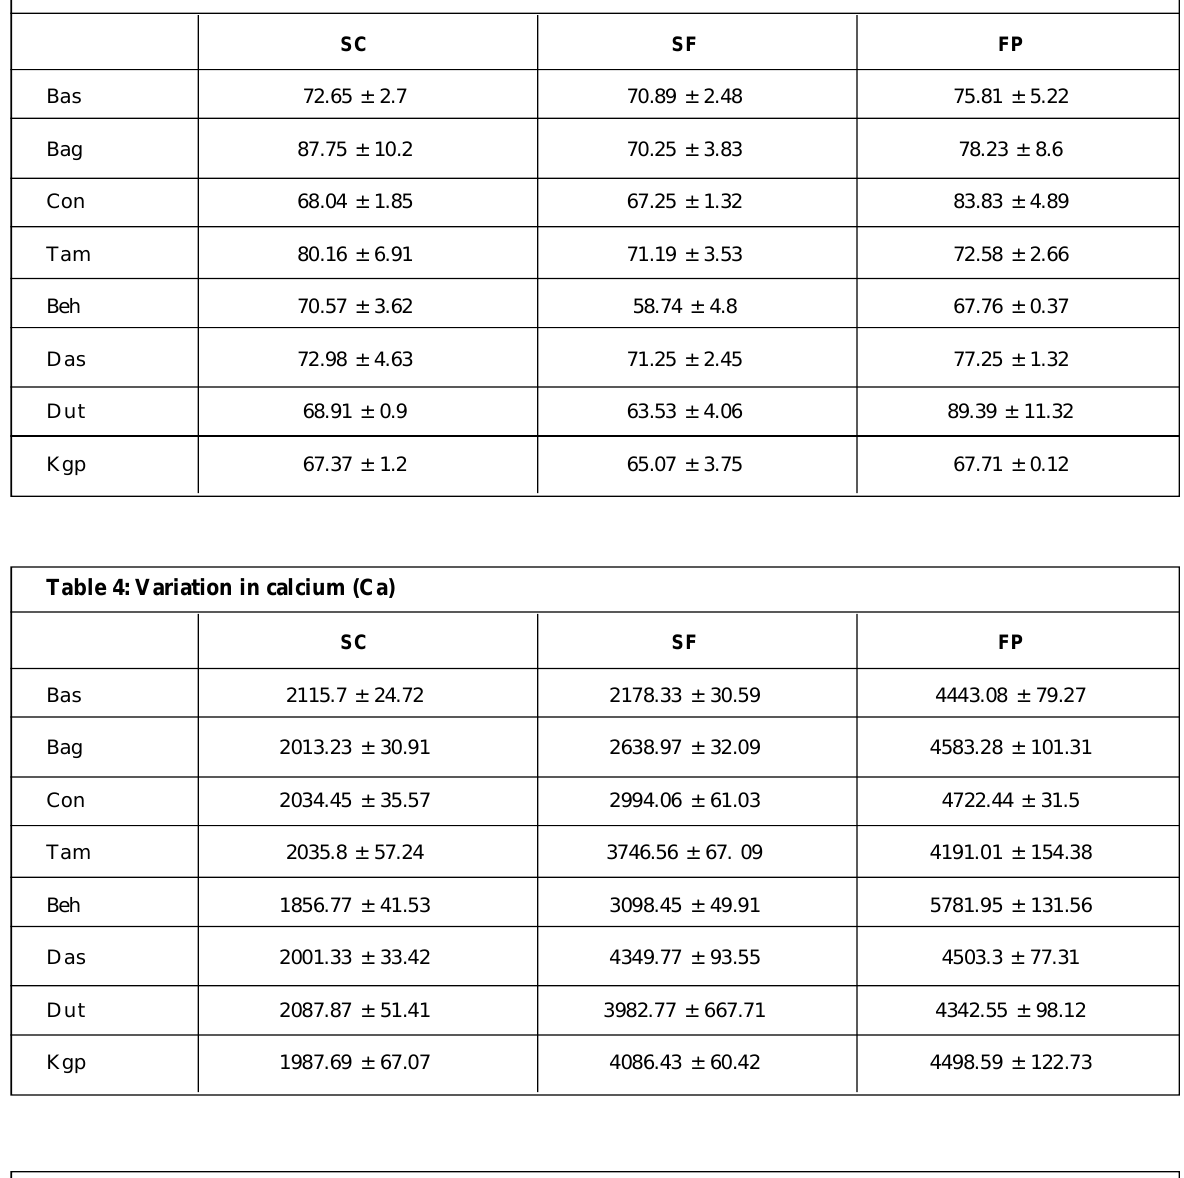
Table 5: Variation in copper